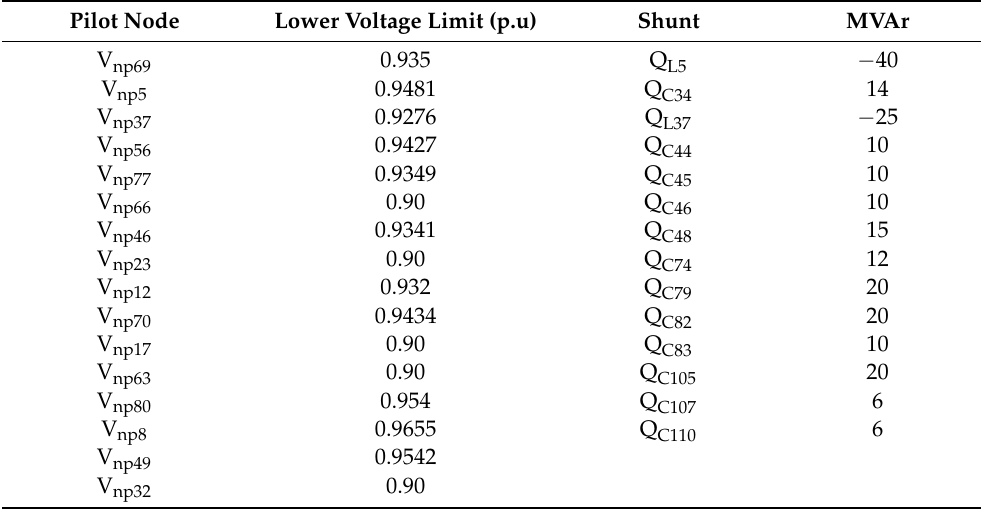
Table 2. Lower voltage limits of pilot nodes and MVAr parameters of shunt elements (IEEE 118-bus test system). Pilot Node Lower Voltage Limit (p.u)